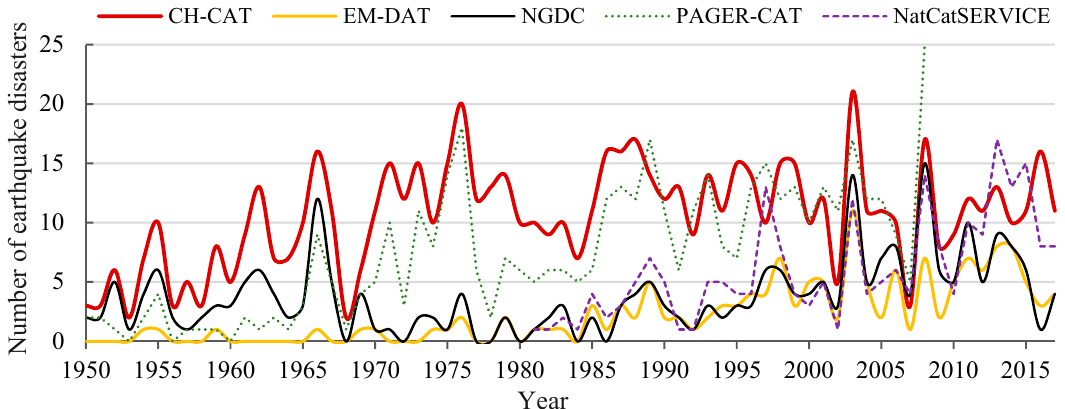
Figure 8. Annual variability in the number of earthquake disaster records in CH-CAT compared with other global earthquake disaster datasets (i.e., Significant Earthquake Database (NGDC), Emergency Events Database (EM-DAT), PAGER-CAT—a composite earthquake catalog for calibrating loss models for the U.S. Geological Survey’s (USGS) Prompt Assessment of Global Earthquakes for Response (PAGER) system, and NatCatSERVICE) during 1950–2017.